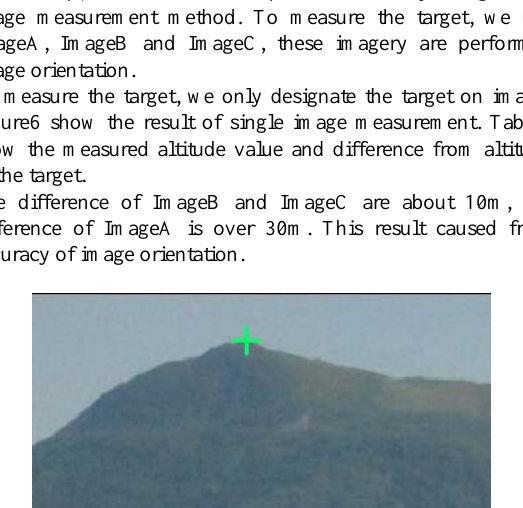
Figure 3. Observation points and Mt. Usu